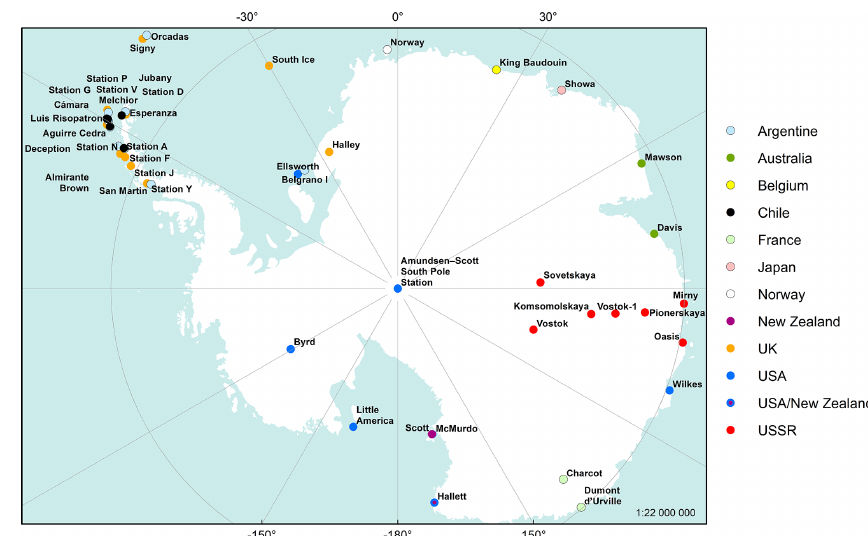
Figure 5. IGY Antarctic research stations of the participating countries.